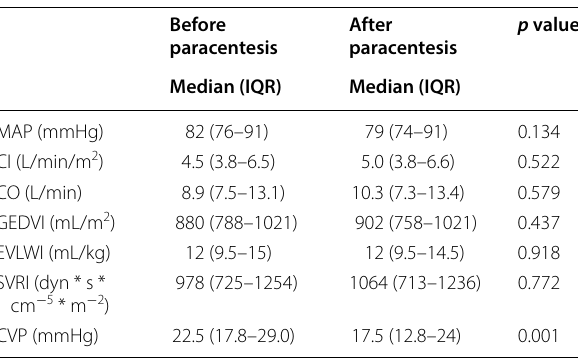
Table 6 Parameters of